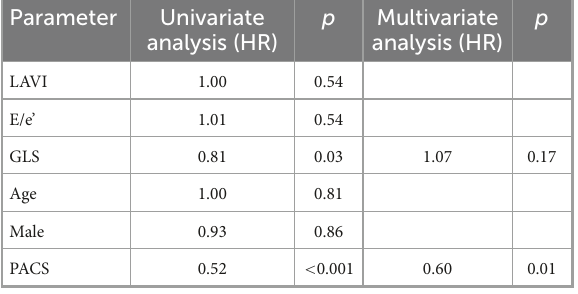
TABLE 3 Univariate and multivariate analysis for the prediction of HF